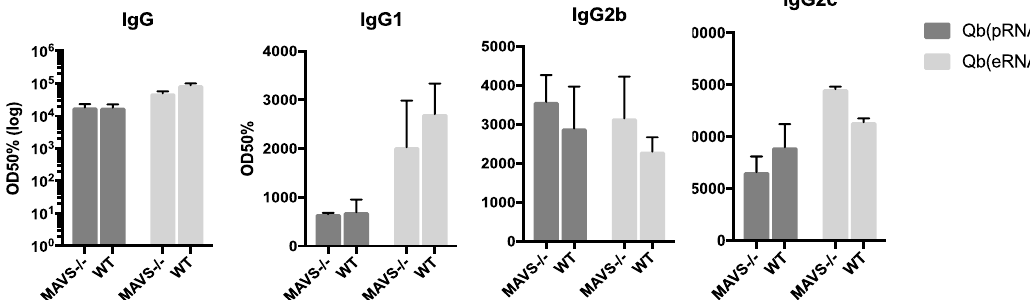
Figure 3. Isotype switching promoted by VLPs is independent of MAVS. Total IgG, IgG1, IgG2b and IgG2c were measured by ELISA 10 days after s.c immunisation with 50 µ g of VLP in age and sex-matched MAVS knock-out and WT counterparts. VLP-specific antibodies. Mean + SEM n = 5. OD50 are titres defined as those dilutions that reached half the maximal OD observed for the assay.